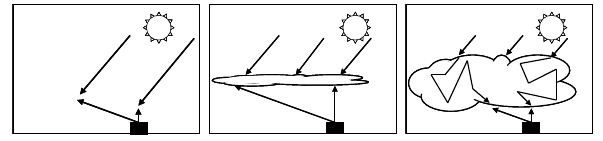
Fig. 10 Schematic description of the cloud influence on MAX-DOAS observations. Left: For clear sky, sun light is scattered by air molecules and aerosol particles towards the instrument. Center: Diffusing screen effect: in the presence of thin clouds, a substantial fraction of the observed photons is scattered by the cloud; especially for the smaller elevation angles, this effect leads to an increase of the absorption path. Right: For optically thick and vertically extended clouds, multiple scattering can lead to very large increase of the photon paths inside the clouds.